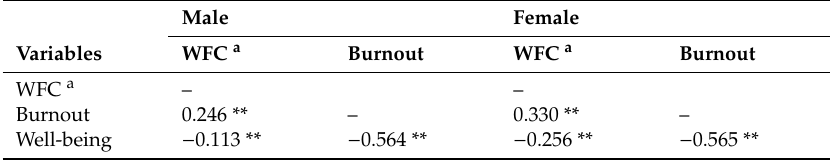
Table 2. The correlations of research variables in male and female workers.